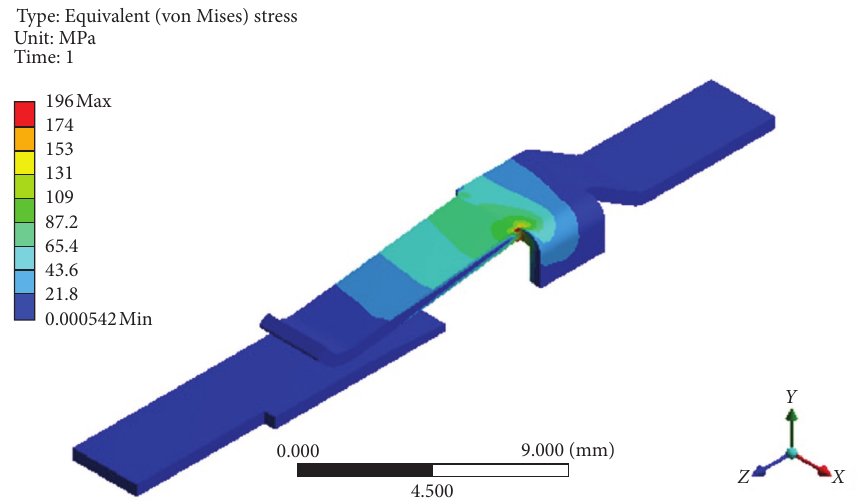
Figure 12: Von Mises stress contour when the interference is 0.1mm.